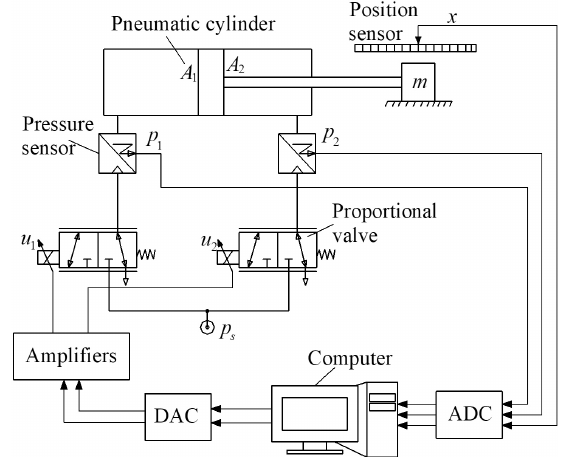
Figure 5. Schematic of the experimental test setup.